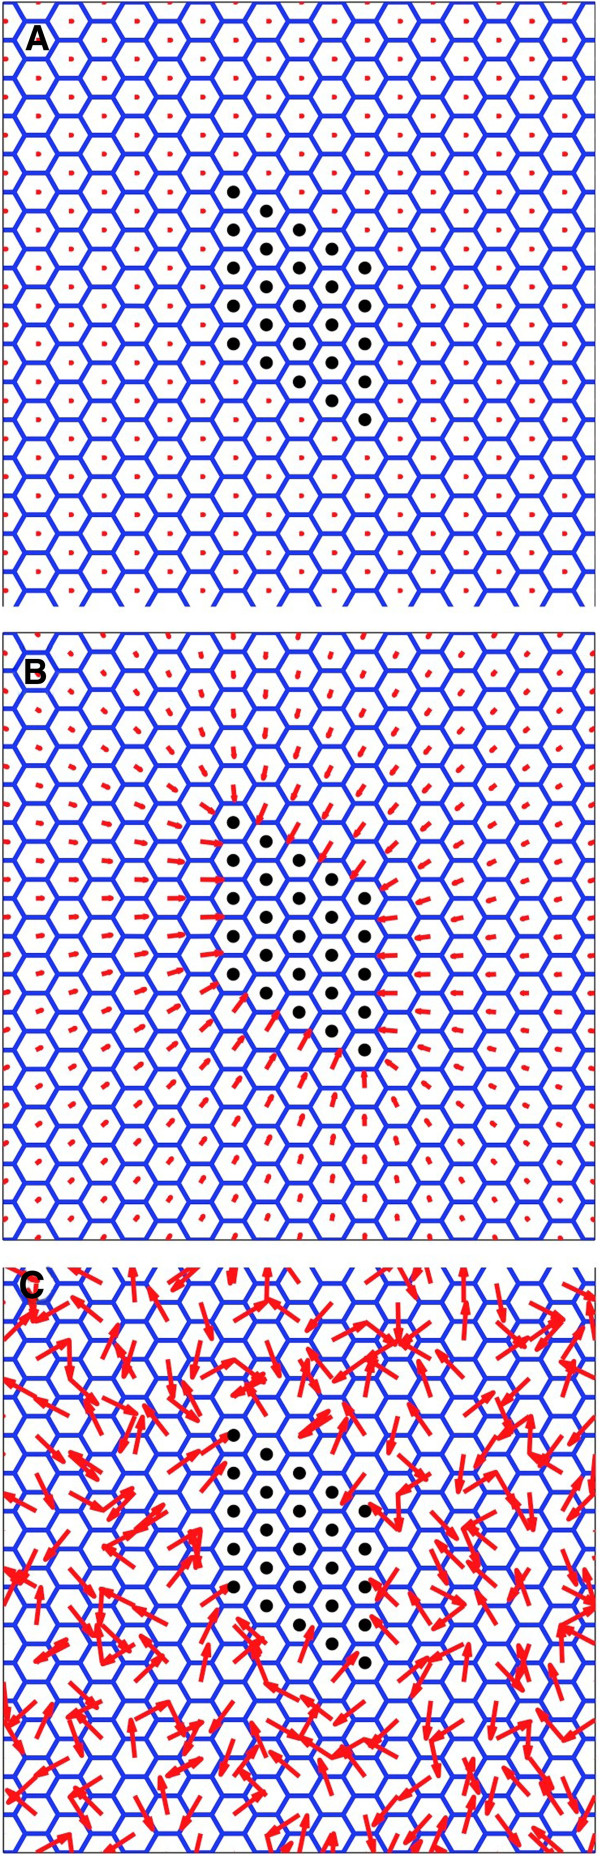
Simulation of clones in a double mutant background. Simulations of double knockouts using attractive (fz) clone simulations. (A) masym= 0, Kalign= 0. (B) masym= 0, CmediatorGcue= 0. (C) Kalign= 0, CmediatorGcue= 0. Repulsive (Vang) clones can be inferred directly by reversing the arrows of the attractive (fz) clones.